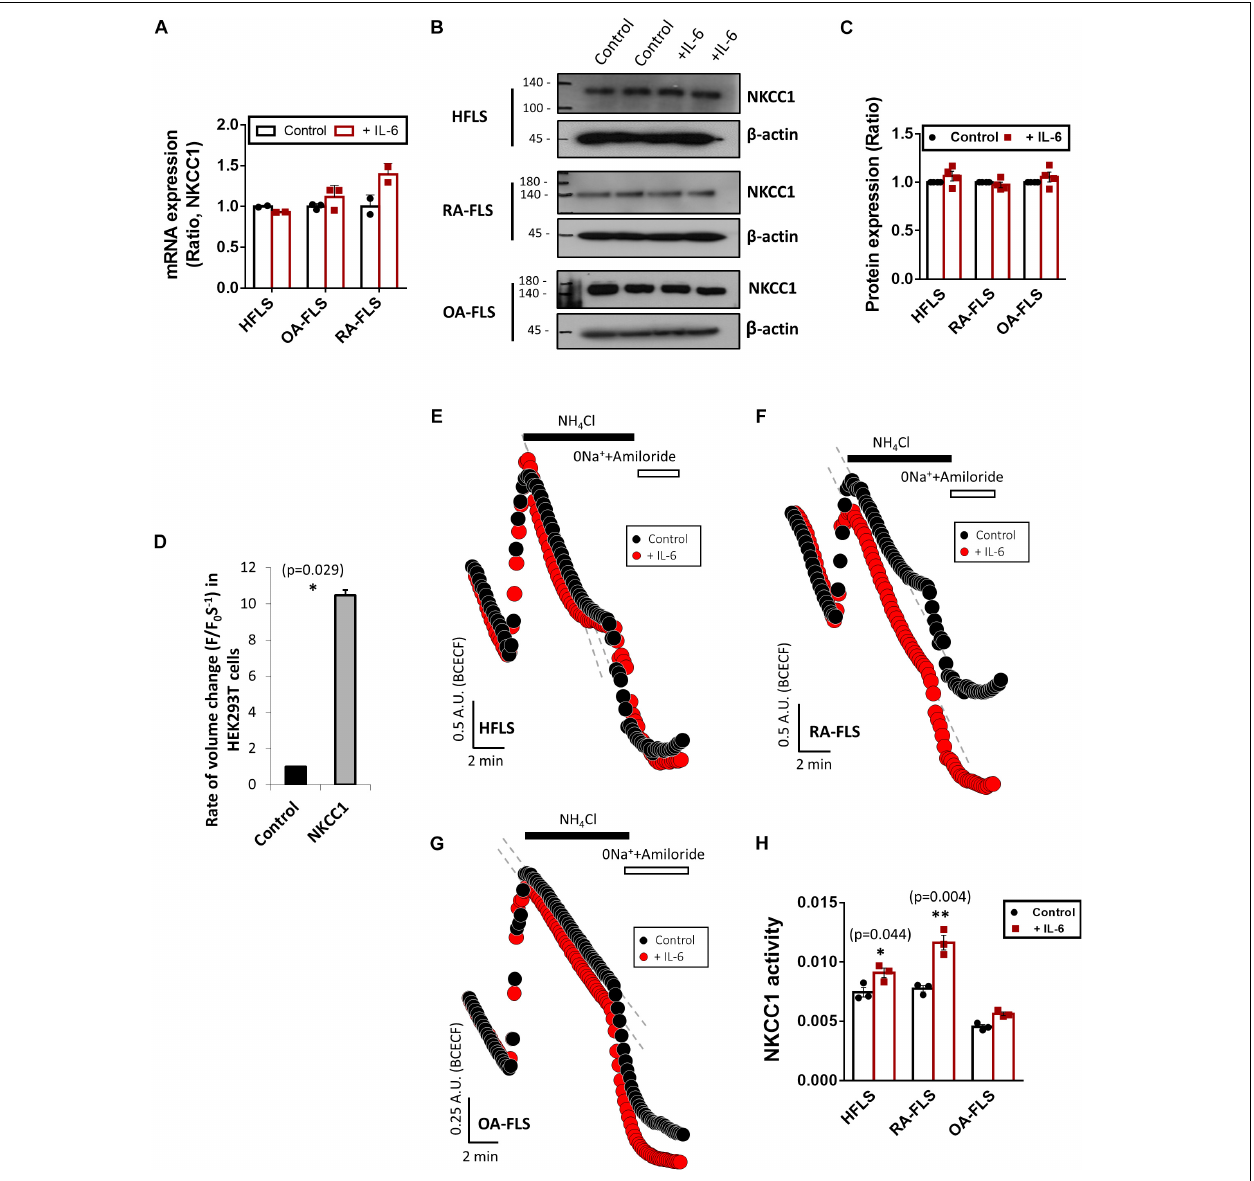
FIGURE 3 | Interleukin (IL)-6 enhanced sodium–potassium–chloride cotransporter 1 (NKCC1) activity in human fibroblast-like synoviocytes (HFLS) and rheumatoid arthritis FLS (RA-FLS). (A) mRNA levels and (B) protein levels of NKCC1 with pretreatment of 50 ng/ml IL-6 for 48 h in HFLS, OA-FLS, and RA-FLS. β -Actin was used as a loading control. (C) Analysis of band intensity of NKCC1 protein levels in HFLS, OA-FLS, and RA-FLS. (D) Rate of volume change by hypertonic stimulation in NKCC1-overexpressed HEK293T cells. Results are shown as mean ± SEM ( n = 3, * p < 0.05, *: Control vs NKCC1). NKCC1 activity due to the 20 mM NH 4 Cl pulse was measured with pretreatment of 50 ng/ml IL-6 in (E) HFLS, (F) RA-FLS, and (G) OA-FLS. (H) Analysis of NKCC1 activity. NKCC1 activity of the IL-6-stimulated groups were normalized to control. Results are shown as mean ± SEM [ n = 3, * p < 0.05, ** p < 0.01, *: Control vs + (IL) −